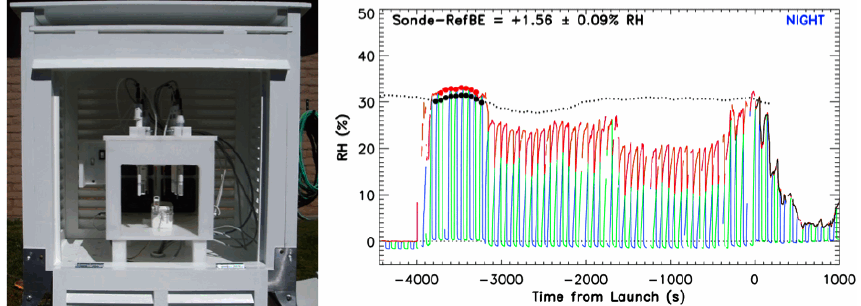
Fig. A1. On the left an RS92 is shown in the THPref, although normally the door is closed and faces north, and it is located away from buildings and other sources of heat or moisture. On the right is an example data comparison showing RH time series from the THPref (black dashed line) and RS92 (red prior to launch at t =0, and black after launch). The large dots are 1-min averages during the comparison period when the RS92 is in the THPref, in this case indicating an RS92 mean bias relative to THPref of +1.6% RH. Green and blue curves represent the individual RS92 RH sensors that are alternately heated, while the other sensor measures where the RS92 RH data (red curve) is given by the combined measurement portions from each sensor. Note that prior to launch, recovery from a heating cycle is incomplete when the RS92 is not being ventilated in the THPref.